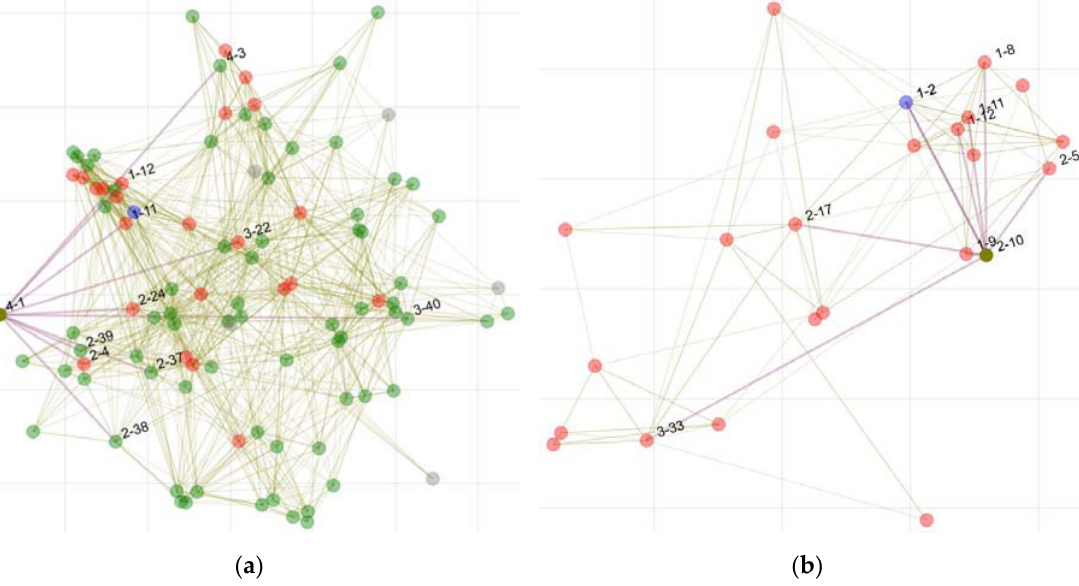
Figure 2. ( a ) Schematic overview of interactions between guests at the event (with individual “4-1” exemplary highlighted). Each guest is represented by a node, and all interactions longer than 10 min and with a distance less than 1.5 m are represented as edges between the nodes. The color of the nodes represents test results after the event: red, infection detected; green, no infection detected; dark green, selected individual for representation; grey, unknown. The blue node represents the putative index. An interactive version of the figure is available under URL 1 (Supplementary materials). ( b ) Contacts between individuals who tested positive after the event (with individual “2-10” exemplary highlighted). An interactive version of the figure is available under URL 2 (Supplementary materials).